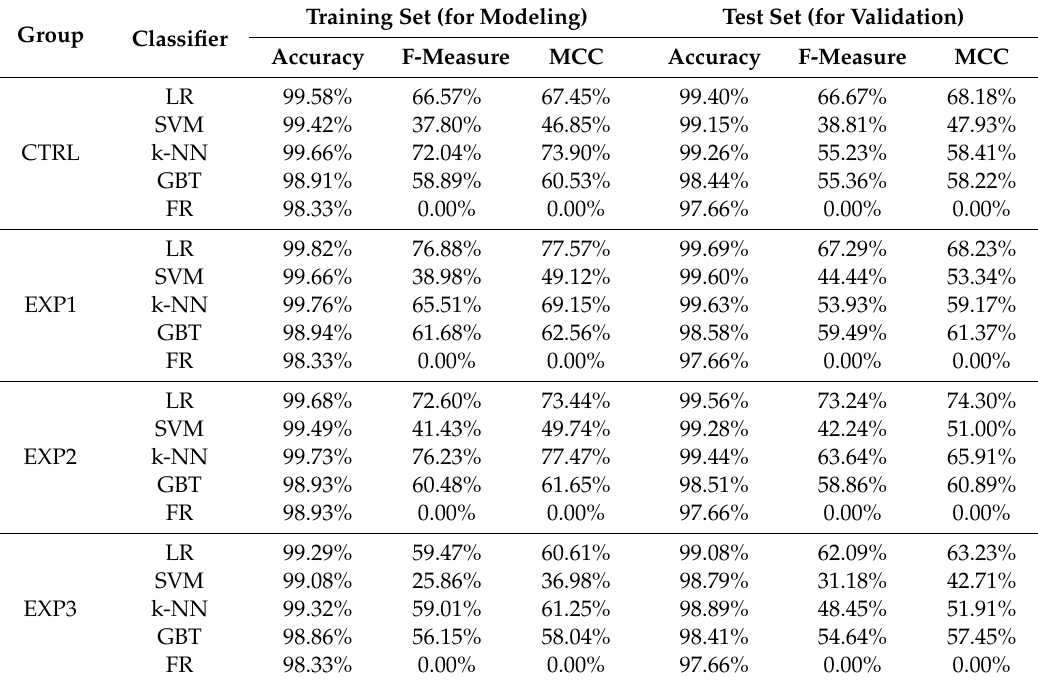
Table 5. Performance results of the five considered classifiers for the control and experimental attribute groups over training and test